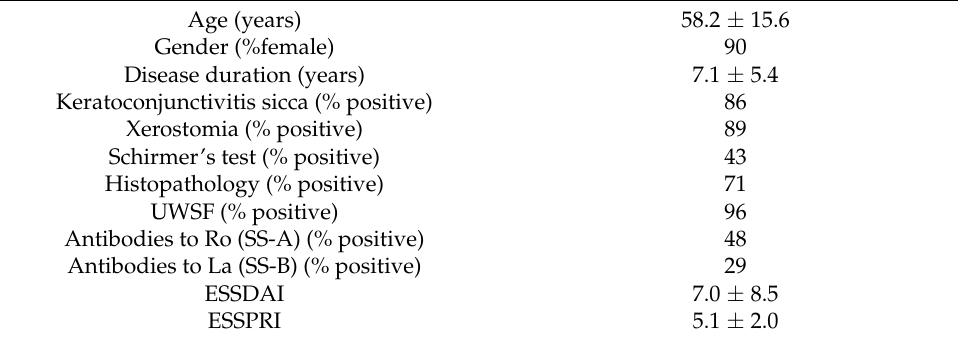
Table 1. Details of the study population ( n = 45) (UWSF = unstimulated whole salivary